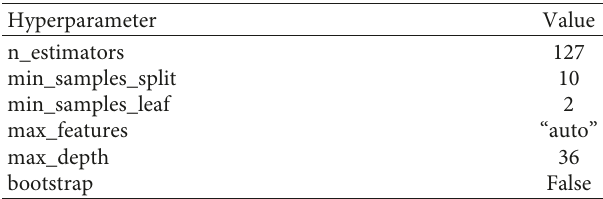
Table 7: Hyper-parameters of RFC